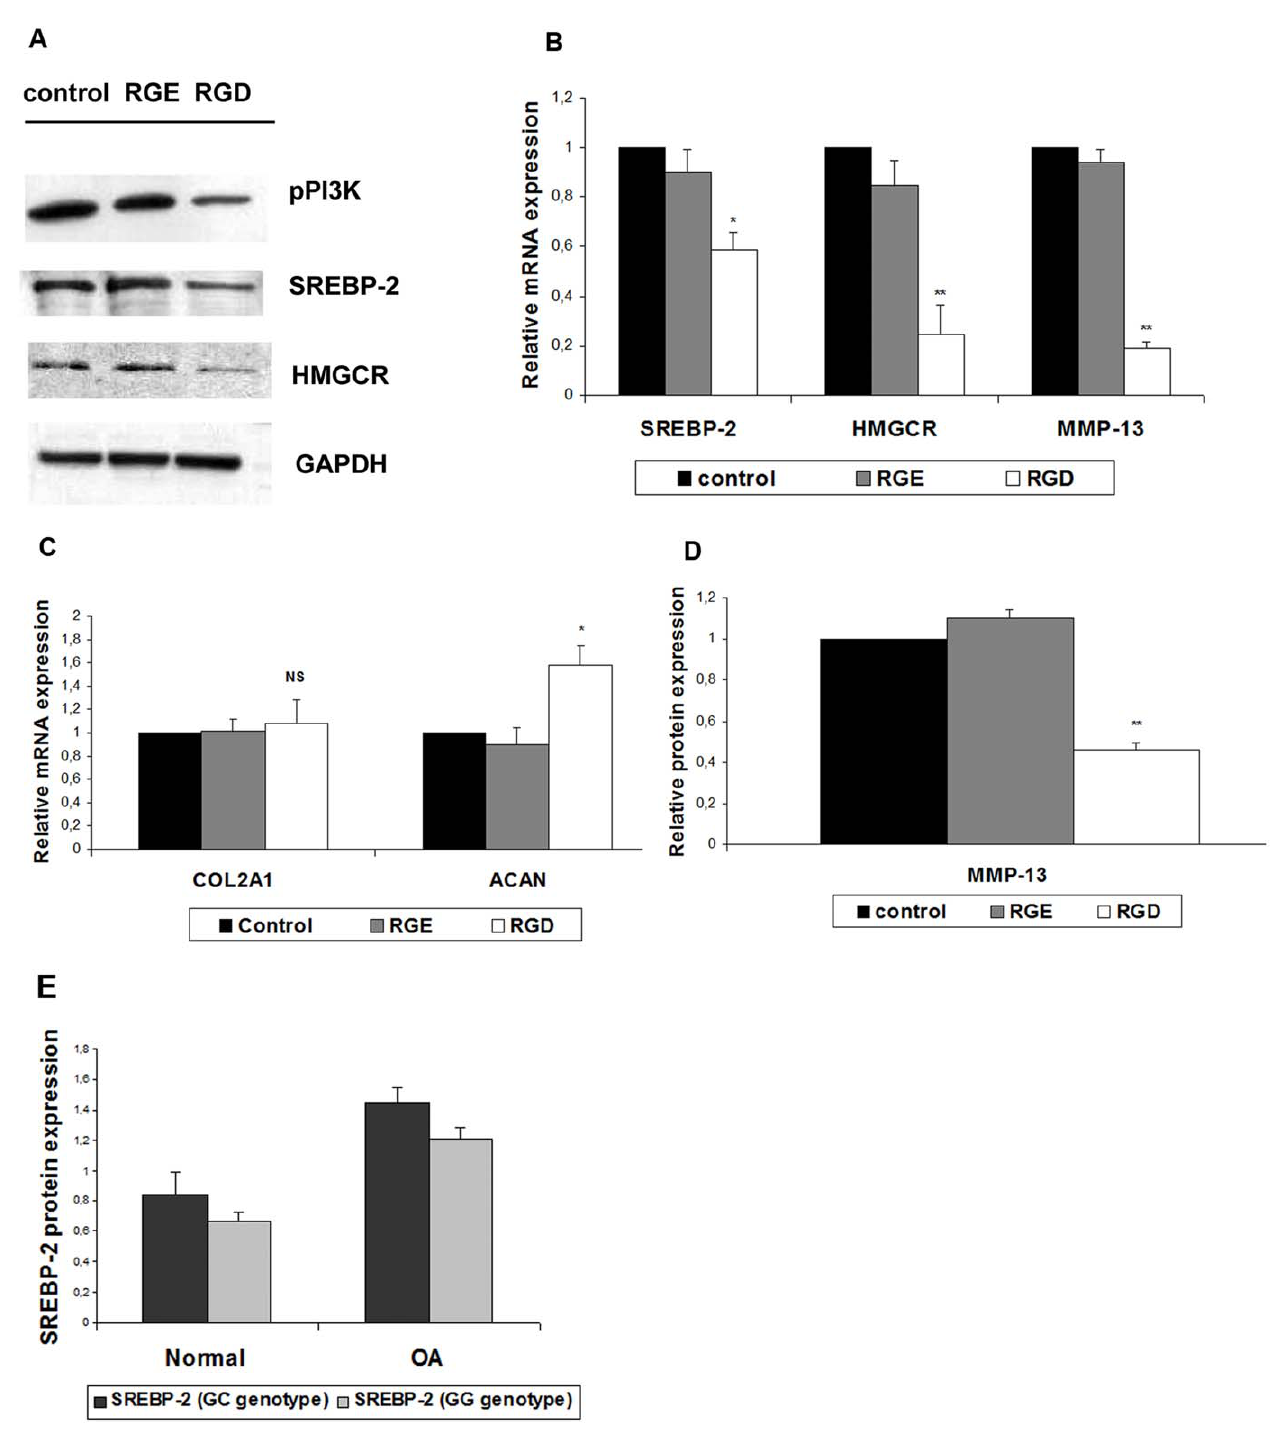
Figure 5. Effect of integrin blockage by cyclo-RGDFV peptide (RGD) on osteoarthritic chondrocytes. ( A ) Effect of treatment of osteoarthritic chondrocytes with 25 m M cycloRGDFV peptide (RGD), control peptide RGE and additional control (untreated cells) for 24 h on SREBP-2, HMGCR and phospho-PI3K protein expression evaluated by Western blot analysis. GAPDH was utilized as loading control. ( B ) SREBP-2, HMGCR and MMP-13, and ( C ) COL2A1 and ACAN mRNA expression in osteoarthritic chondrocytes treated with RGD, RGE and respective control using Real Time PCR. GAPDH was used for normalization of the Real Time PCR data. All experiments were performed in duplicate and data are expressed as mean of two independent experiments. ( D ) MMP-13 expression levels in osteoarthritic chondrocytes following treatment with RGD, RGE and respective control detected by ELISA. *p , 0.05, **p , 0.001, NS: non-significant ( E ) SREBP-2 protein expression in normal and OA chondrocytes compared to genotypes (GG and GC) of the 1784G/C SNP.